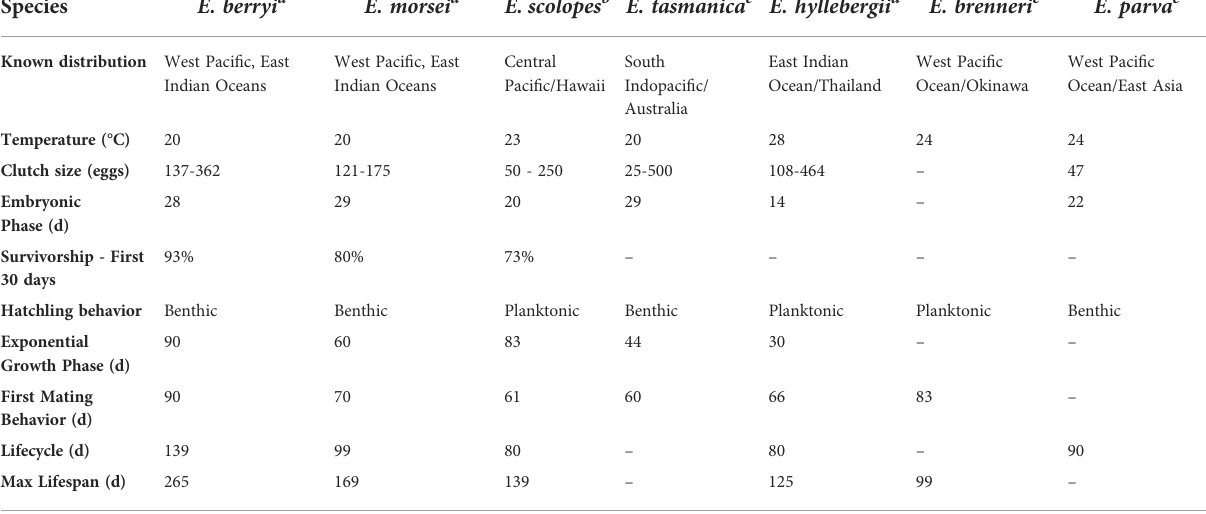
TABLE 2 Comparison of life cycle and culture traits of cultured Euprymna spp.